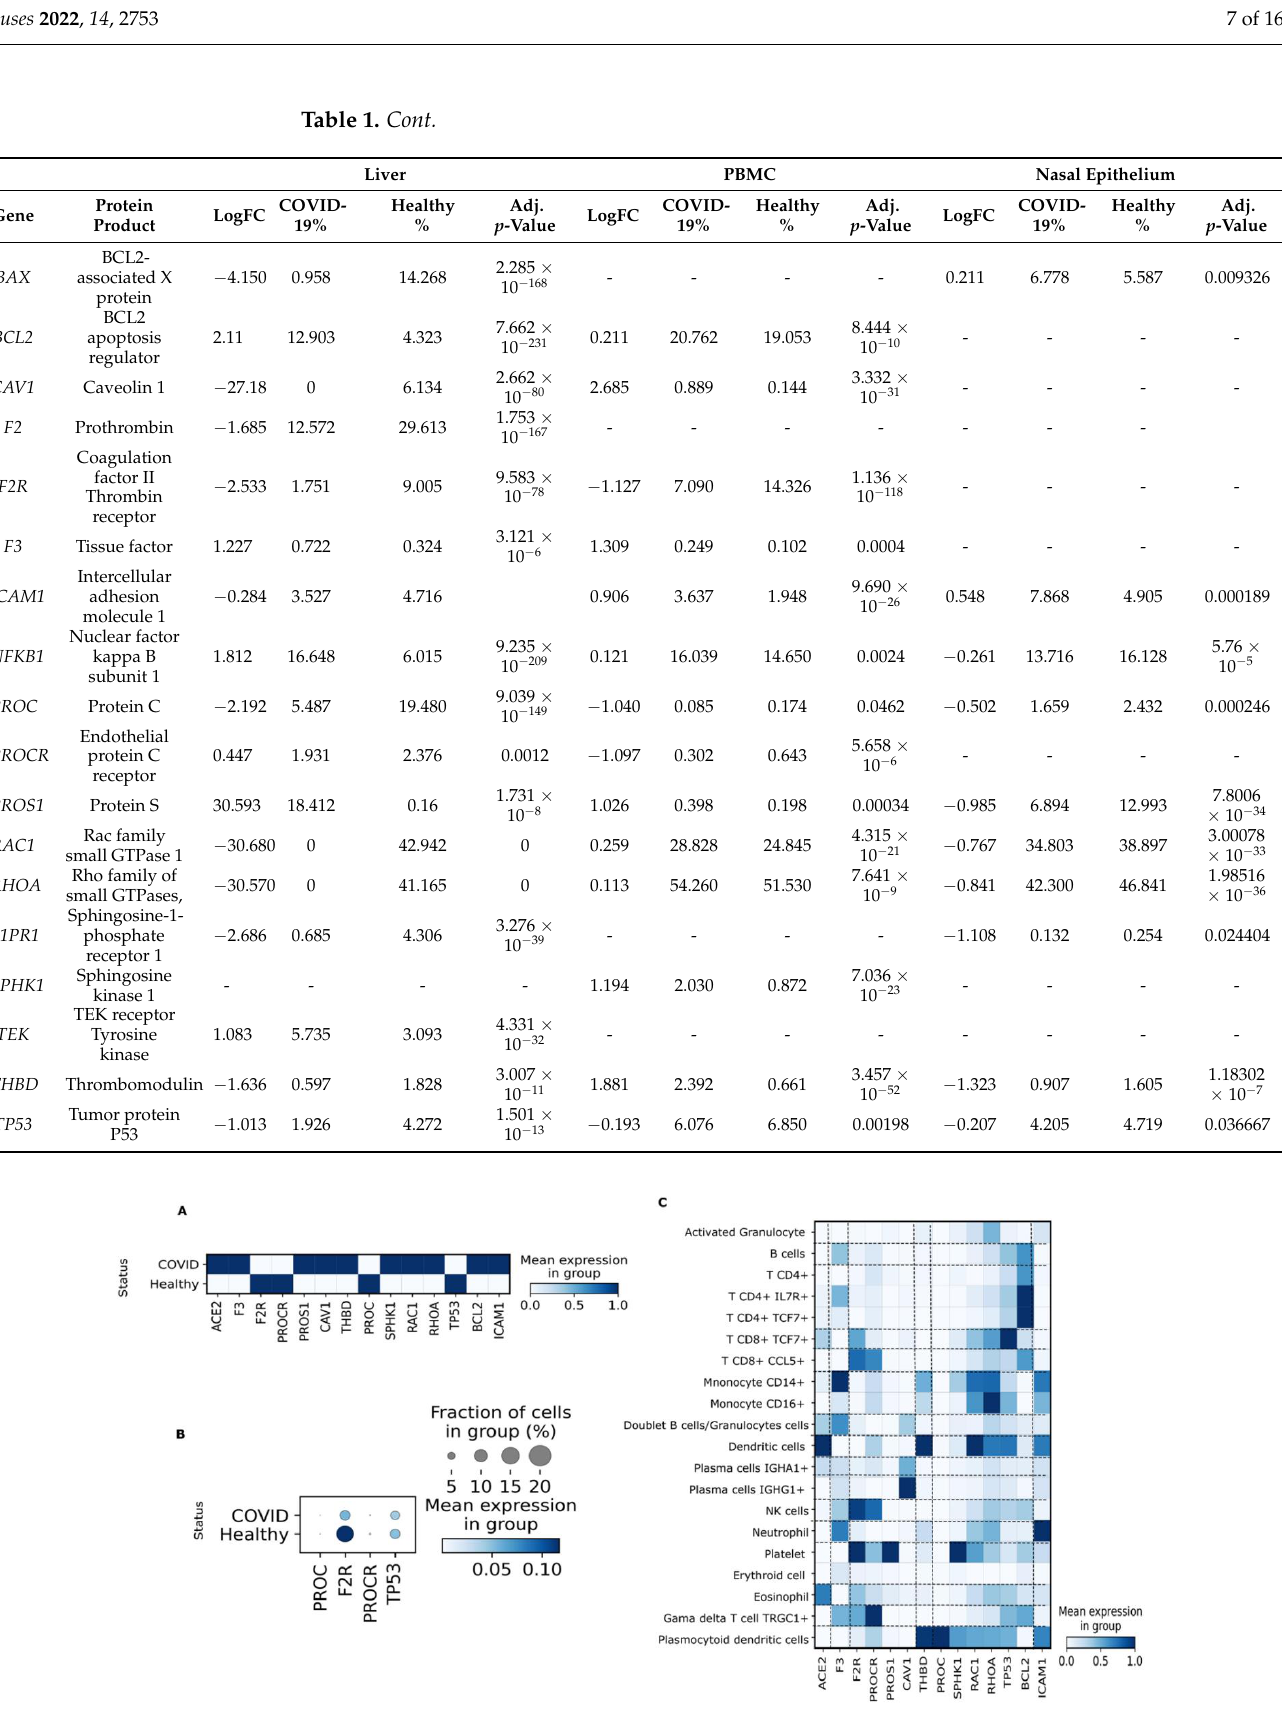
Figure 3. Expression of genes involved in activated protein C (APC) signaling in human peripheral blood mononuclear cells (PBMC) from patients with coronavirus disease 2019 (COVID-19) based on single-cell transcriptomics. ( A ). Matrix plot showing expression of genes related to APC signaling in patients with COVID-19 versus healthy individuals. ( B ). Dot plot representation of downregu- lated genes in patients with COVID-19. ( C ). Matrix plot showing expression of the main genes re- lated to APC signaling according to cell types. Liver. PC synthesis occurs mainly in hepatocytes, and it is released into the blood- stream as a zymogen [19]. First, we determined the expression of the PROC gene in healthy liver parenchyma and then compared the expression to samples collected from autopsies of patients who died because of severe COVID-19 complications. PROC was expressed throughout the liver parenchyma of healthy individuals, particularly in hepato- cyte 4 (ADH1B + /PCK1 + ), which displayed the highest expression (Figure 2B). ACE2 ex- pression was restricted to cholangiocytes in the healthy liver; the main receptors involved in PC signaling — PROCR , F2R , S1PR1 , THBD, and TEK — were detected in endothelial cells (Figure 2B). In liver autopsy samples from patients who died because of COVID-19 complications, PC activation signaling receptors were significantly decreased compared with control as follows: 2.7-fold for S1PR1 , 2.5-fold for F2R and 1.7-fold for THBD ( p < 0.001), and less than 5% of cells expressed these genes (Table 1; Figure 2C,D). Conversely, liver samples from patients with COVID-19 presented a significant 1.9-fold increase in AGTR1 , a 1.8-fold increase in NFKB1, and a 1.2-fold increase in F3 ( p < 0.001) (Table 1; Figure 2C). Additionally, there was a significant 2.192-fold decrease in PROC in liver sam- ples from individuals who died from COVID-19 complications ( p < 0.001) (Table 1; Figure 2C). The relative number of hepatocytes from patients with COVID-19 expressing PROC was lower (about 5%) than in healthy individuals (about 20%) (Table 1; Figure 2D). The highest expression of PROC occurred in hepatocyte 3 (ATP5L + ), followed by hepatocytes 9 (ADH1B + ), 5 (A1CF + ), and 6 (PTP4A1 + ) (Figure 2E). ACE2 gene expression was 2.868-fold higher in patients with COVID-19 ( p = 0.000) (Table 1), and the expression was no longer restricted to cholangiocytes (as in the healthy liver) but extended to the liver parenchyma. ACE2 was expressed by hepatocytes 9 (ADH1B + ), 5 (A1CF + ), 6 (PTP4A1 + ), and 2 (FHIT + ) with low PROC co-expression (Figure 2E,F). Moreover, there was a very strong association between ACE2 and PROC gene expression in samples from patients with COVID-19 be- tween the cells that co-expressed these two genes (Figure 2G).